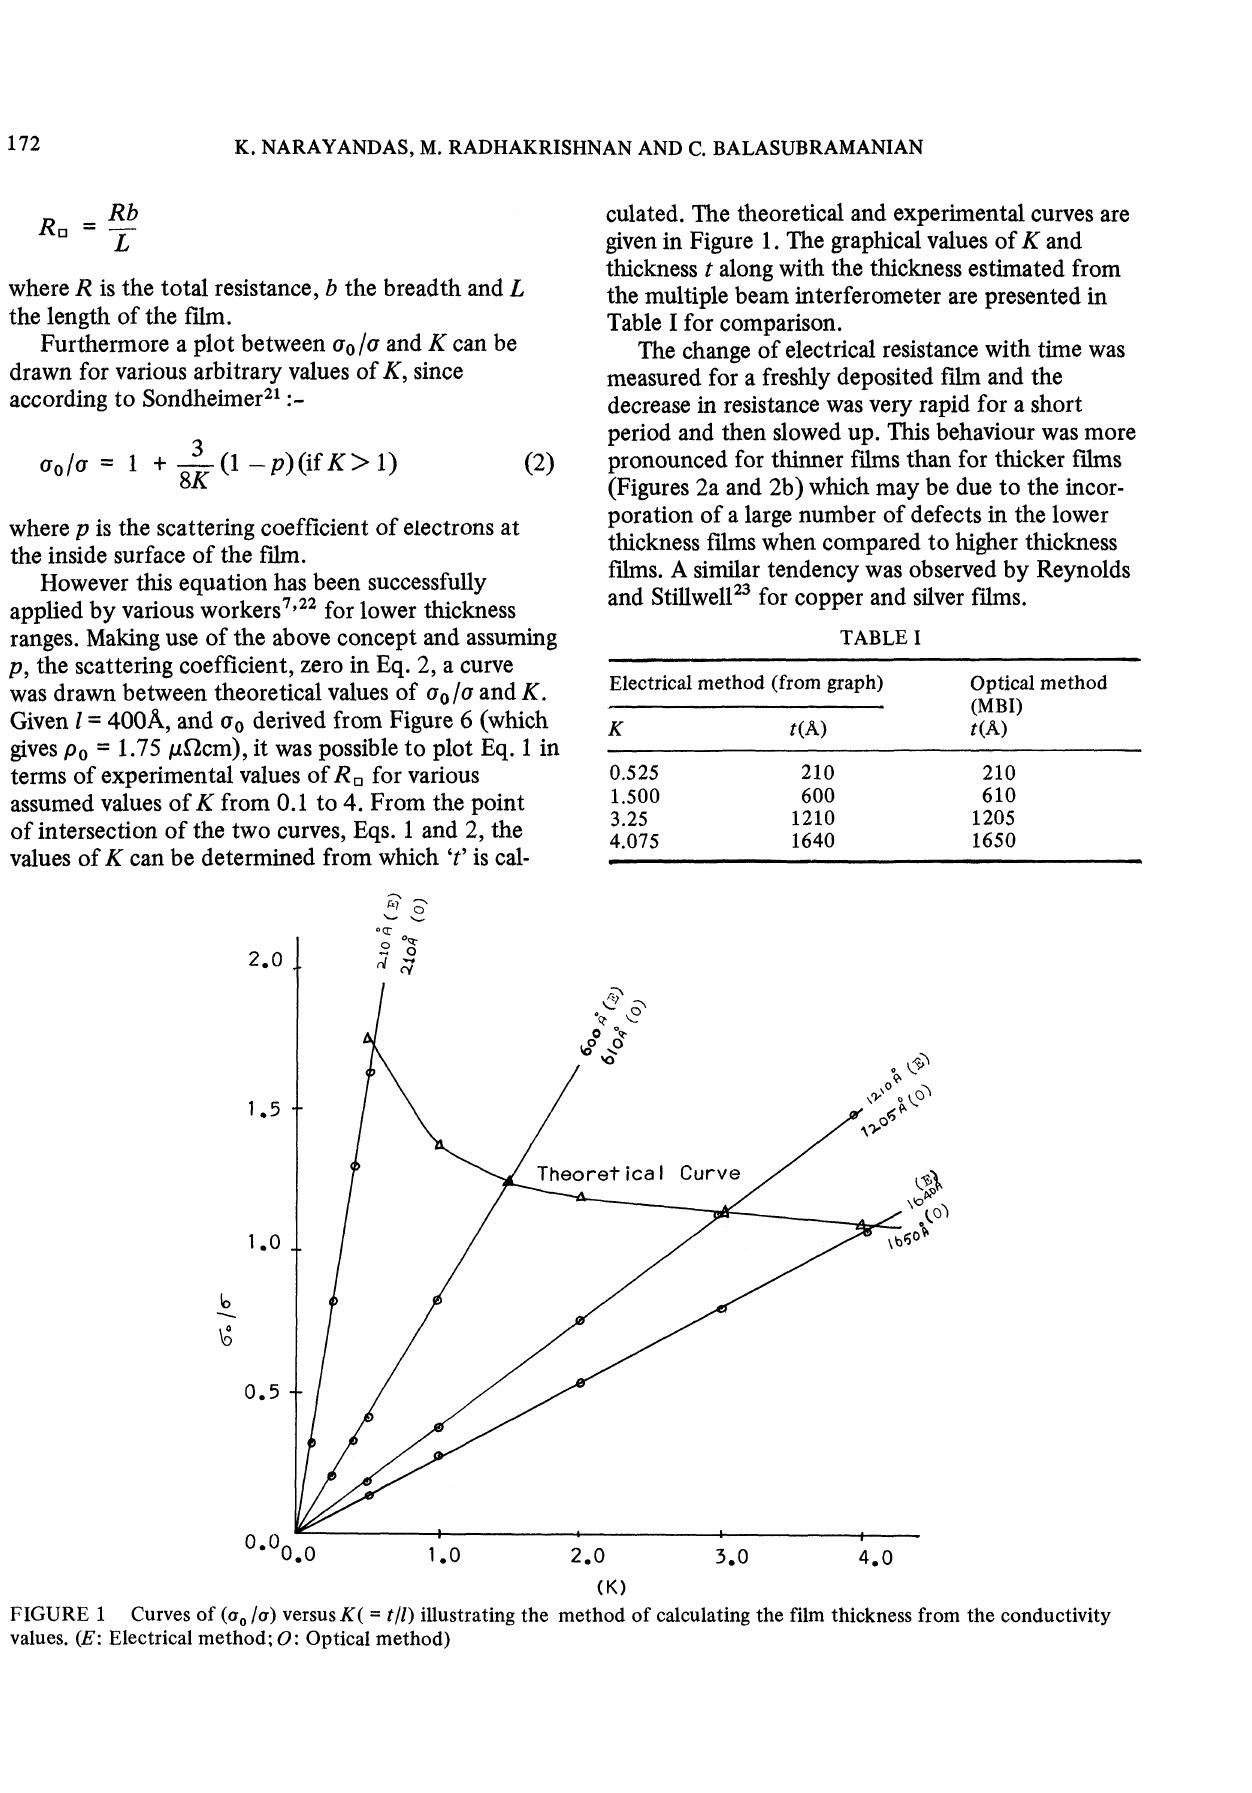
Curves of (%/r) versus K( t/l) illustrating the method of calculating the film thickness from the conductivity values. (E: Electrical method; O’ Optical